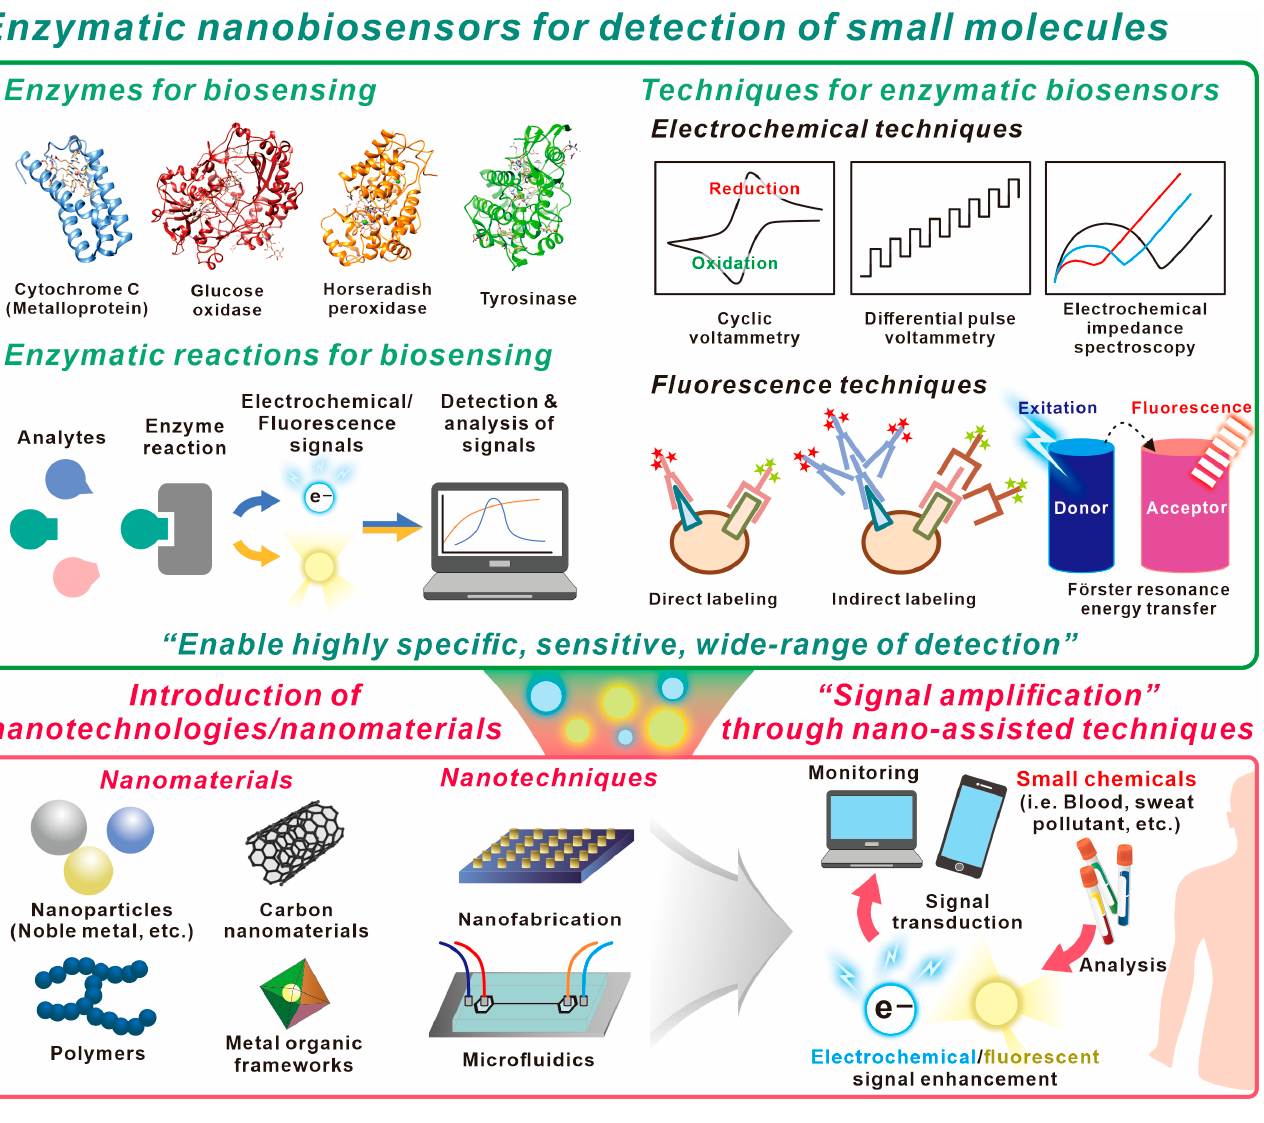
Figure 1. Schematic diagram of enzymatic electrochemical/fluorescent nanobiosensor for detection of small chemicals.